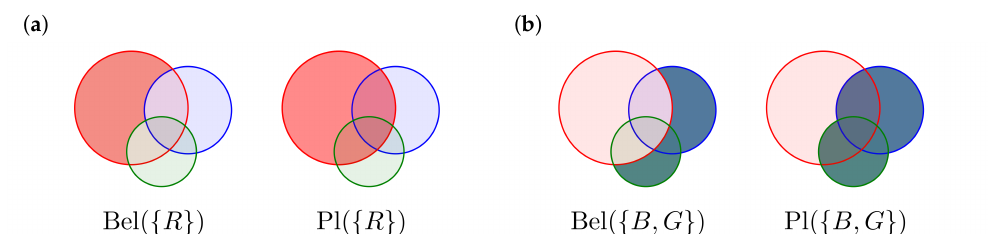
Figure 3. Belief Bel ( S ) and Plausibility Pl ( S ) illustrated by overlapping disks. The size of arrays represents basic believe masses. The difference between plausibility and believe Pl ( S ) \ Bel ( S ) is called uncertainty. ( a ) Bel { R } and Pl { R } of the singleton { R } . ( b ) Bel { B , G } and Pl { B , G } of the set { B , G }